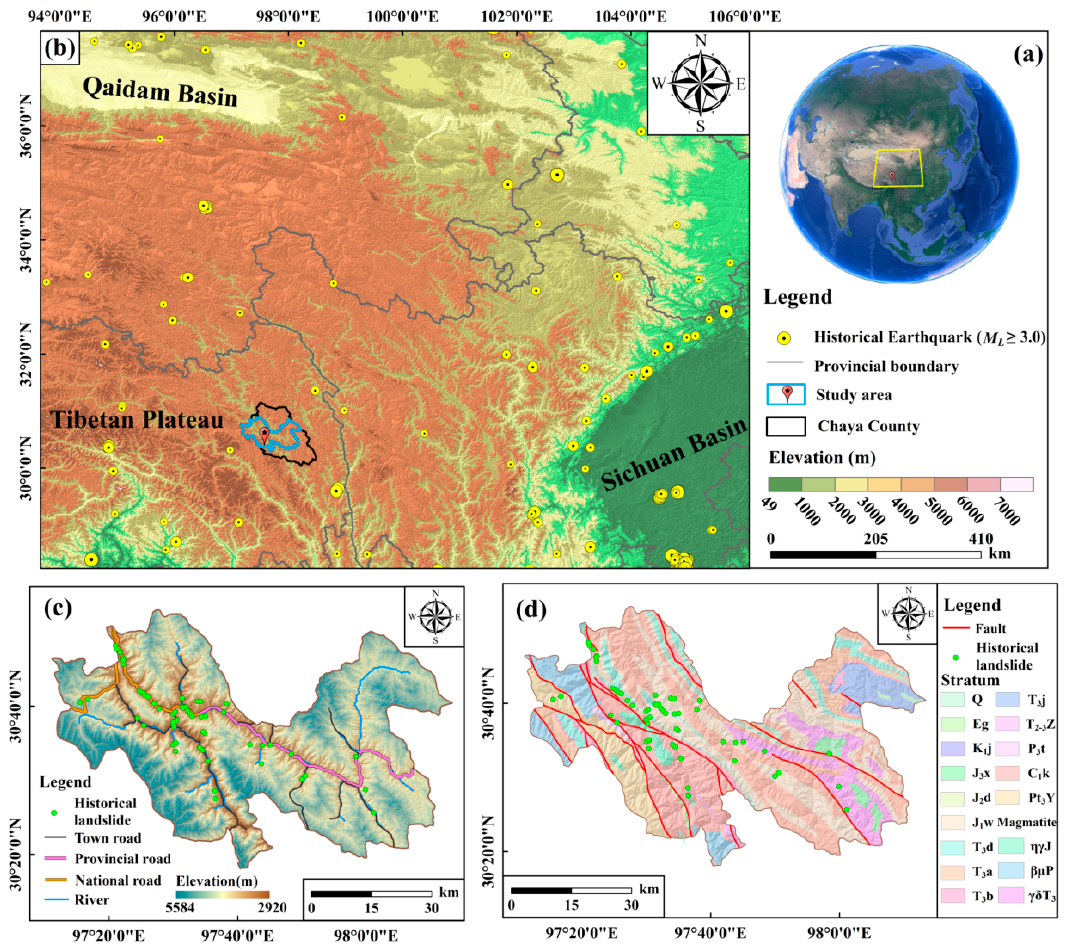
Figure 1. Geological and seismotectonic setting of the study area. ( a ) Location of the study area in China. ( b ) Location of the study area in the Tibetan Plateau. ( c ) Main roads, developed rivers, and historical landslides in the study area. ( d ) Strata and fault tectonics in the study area (1:200,000 geological map). The symbols include: Q = Quaternary; Eg = Gongjue Formation of Paleogene age; K 1 j = Jingxing Formation of Early Cretaceous age; J 3 x = Xiaosuoka Formation of Late Jurassic age; J 2 d = Dongdaqiao Formation of Middle Jurassic age; J 1 w = Wangbu Formation of Early Jurassic age; T 3 d = Duogaila Formation of Late Triassic age; T 3 a = Adula Formation of Late Triassic age; T 3 b = Bolila Formation of Late Triassic age; T 3 j = Jiapeila Formation of Late Triassic age; T 2–3 Z = Zhuka Formation of Middle and Late Triassic age; P 3 t = Tuobei Formation of Late Permian age; C 1 k = Kagong rock group of Early Carboniferous age; Pt 3 Y = Jiuxi Formation of Proterozoic era; ηγ J = Monzonitic granite of Jurassic age; γδ T 3 = Granodiorite of Late Triassic age; and βμ P = Dolerite of Permian age. The Earth image is sourced from Google Earth.